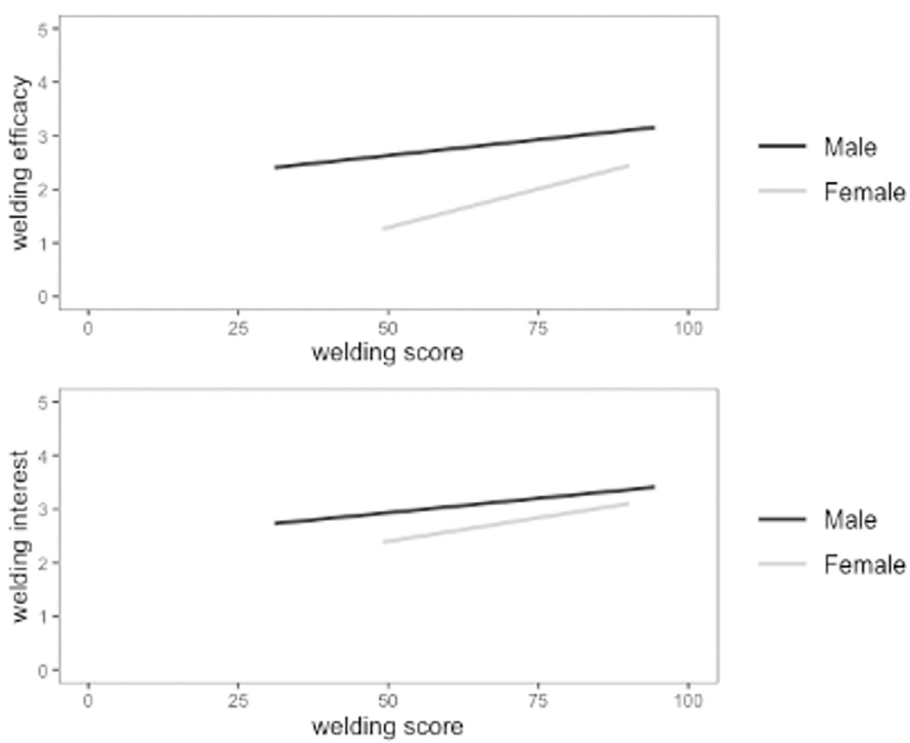
Fig 3. Gender did not moderate the relationships between performance and welding self-efficacy and interest in the desktop simulation condition. Interaction effect of gender and performance on welding self-efficacy (top) and interest (bottom) for desktop simulation. The darker line represents males and the lighter line represents